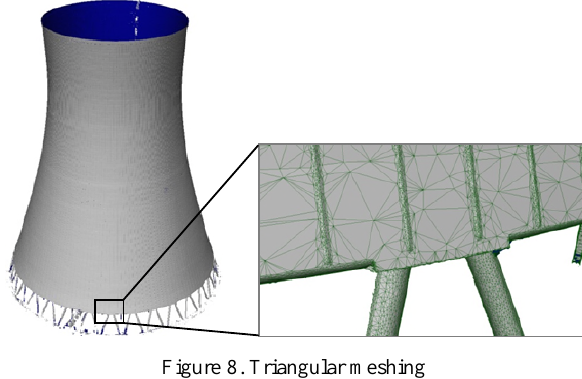
Figure 8. Triangular